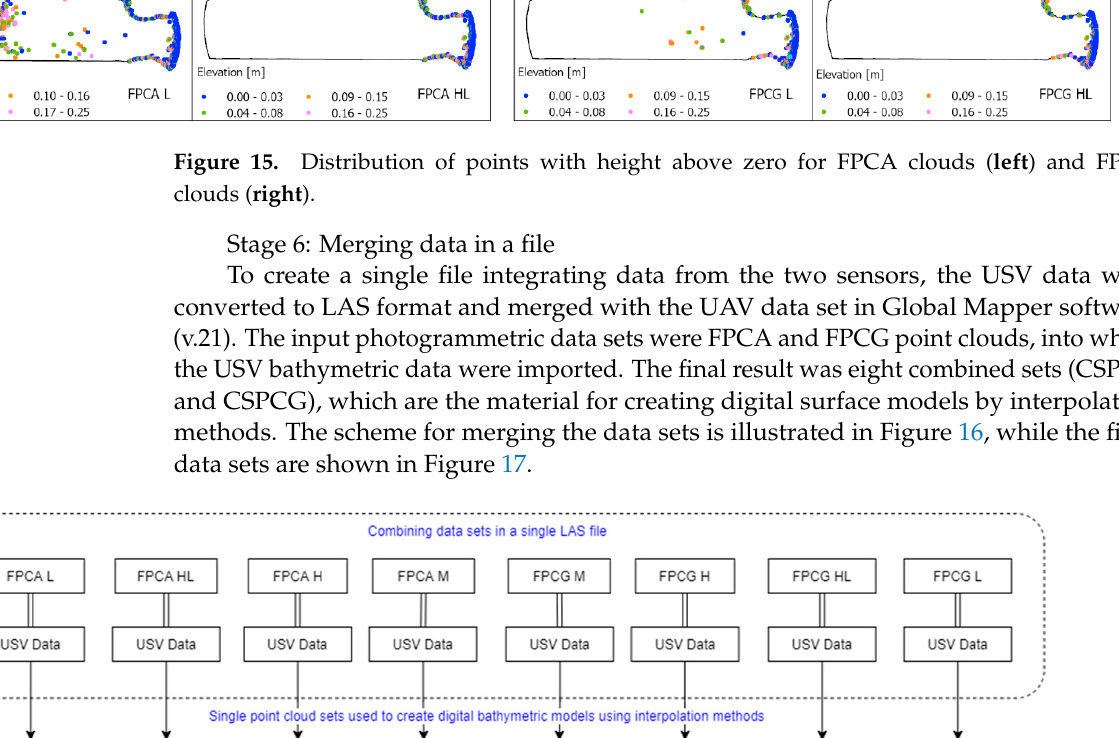
Figure 16. Scheme for the integration of data sets.